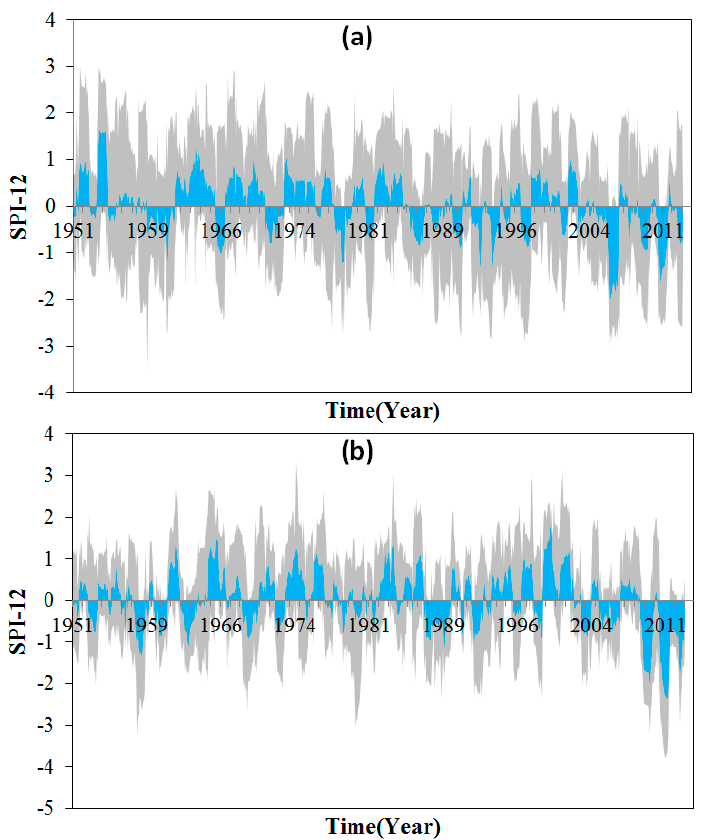
Figure 4. The SPI values for 1951–2013 for ( a ) Sichuan basin and ( b ) Southwest China.